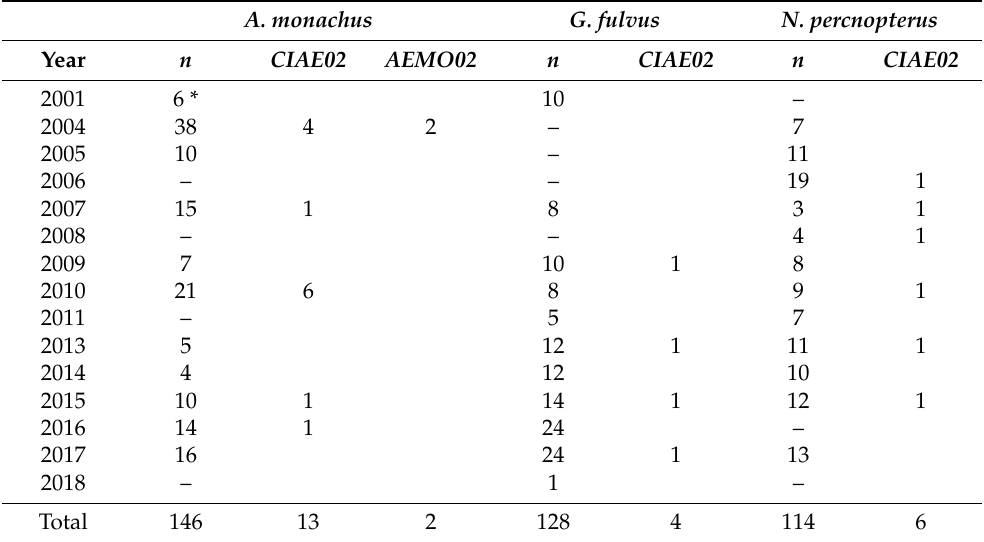
Table 1. Total number of sampled nestlings of three vulture species with specific sample sizes given for each year ( n ), and number of infected nestlings by the corresponding Leucocytozoon lineage. A. monachus G. fulvus N.